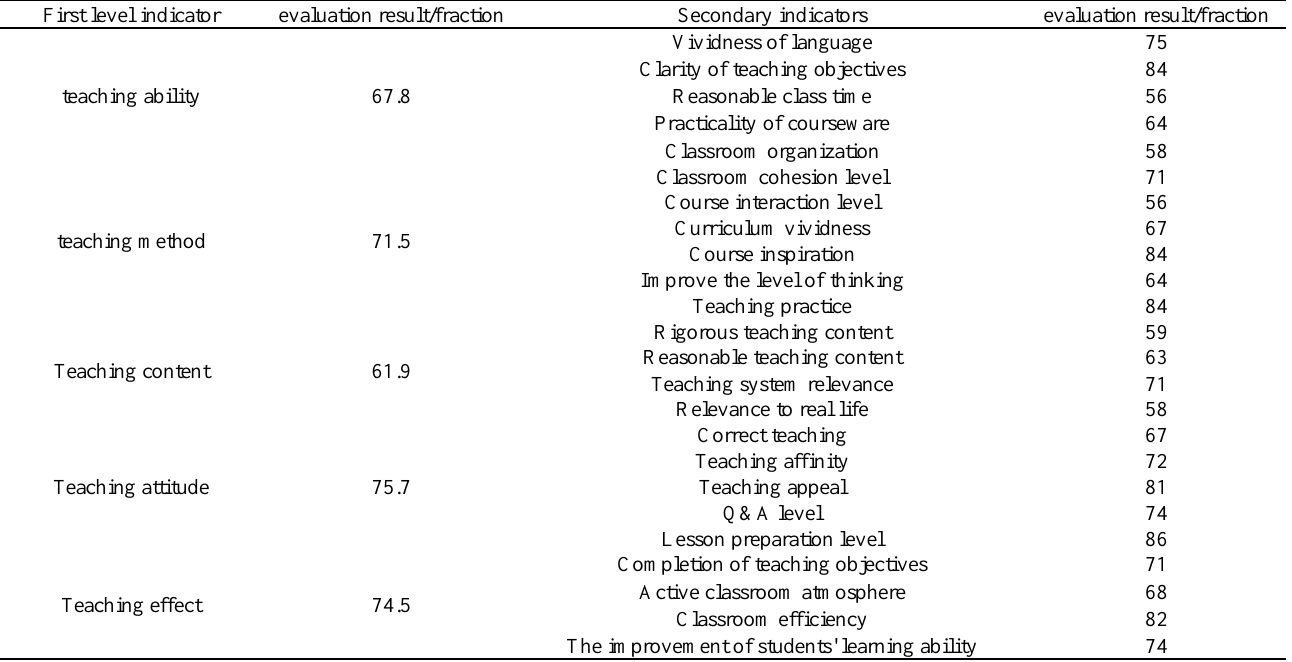
Table 2. Quality evaluation results of construction engineering pricing courses